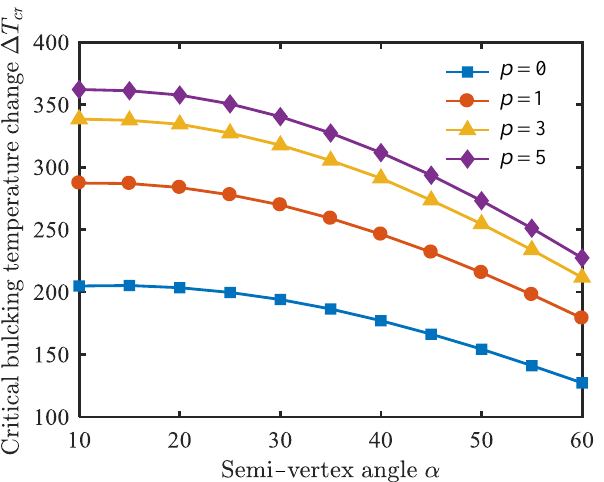
Figure 7. Influence of the semi-vertex angle of the conical shell on critical buckling tempera- ture